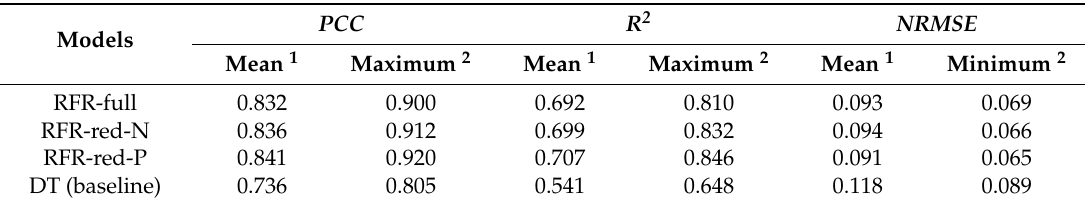
Table 3. Predictive performances of the RFR and baseline models.